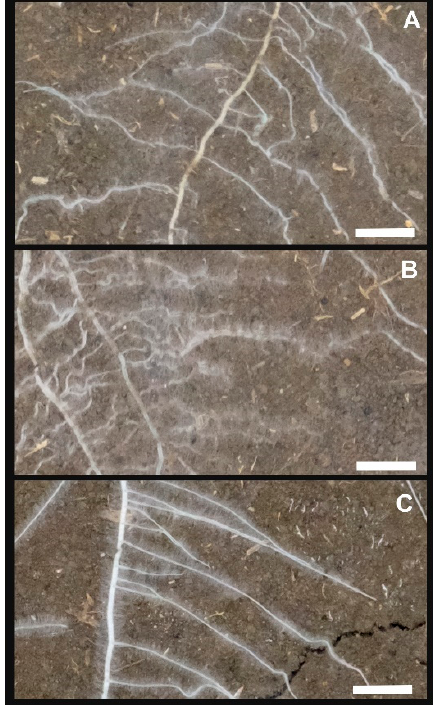
Figure 3. Species with strong root hair formation. ( A ) F. esculentum , ( B ) P. tanacetifolia , ( C ) H. annuus . White bar at the bottom right side of the images is 1.0 cm.